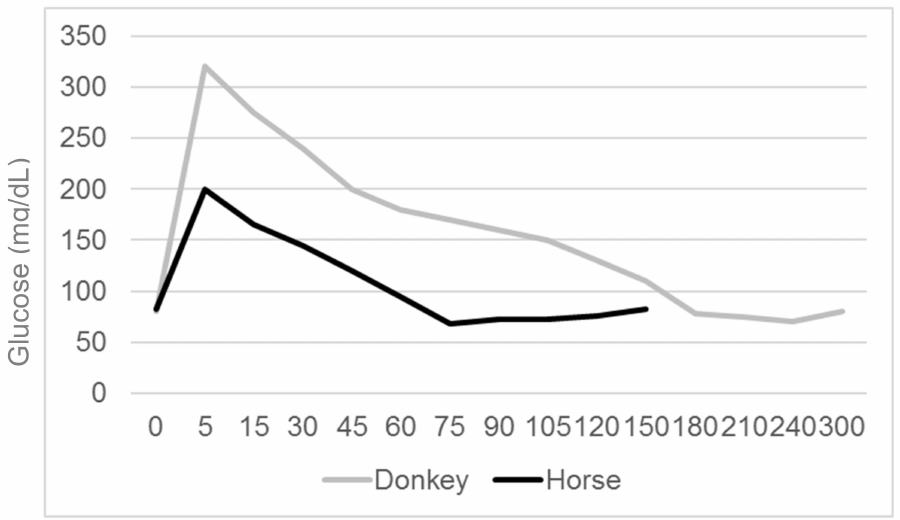
Figure 4. Typical intravenous glucose tolerance test in donkeys compared to